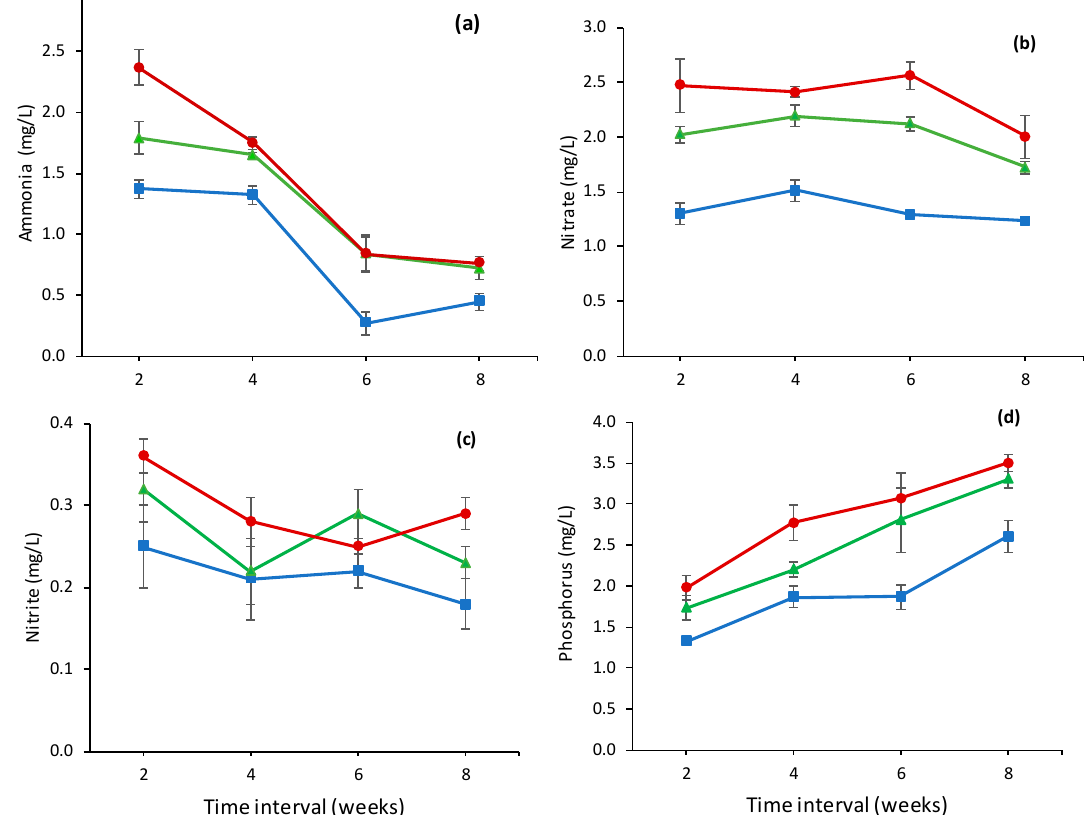
Figure 2. Trends in ammonia ( a ), nitrate ( b ), nitrite ( c ) and phosphorus ( d ) concentrations at the outlet from D1 (blue), D2 (green) and D3 (red) aquaponic units during the experiment. Points are means of three treatment replicates and error bars show standard